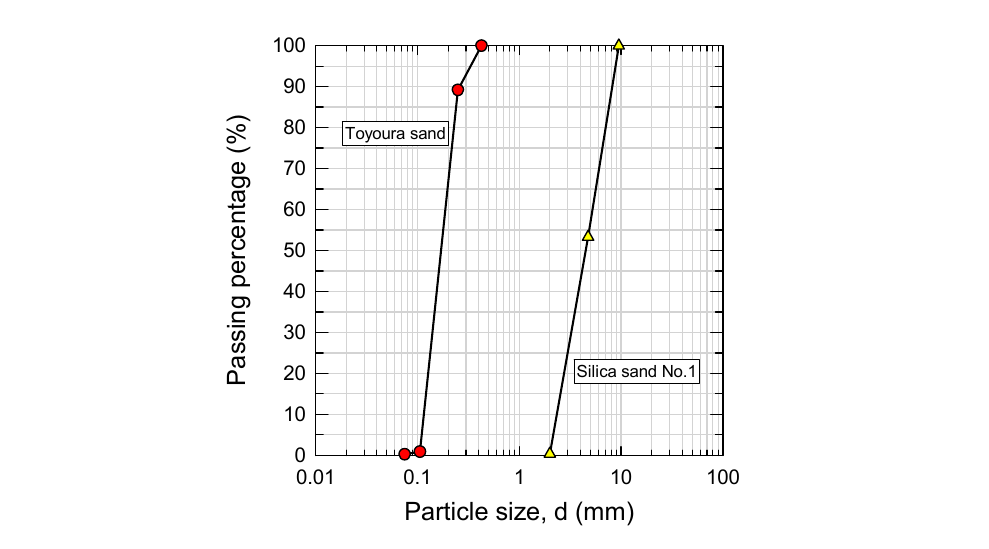
Figure 2. Grain size distribution curves of Toyoura sand and silica sand No. 1. Table 1. Physical properties and hydraulic conductivities of the soil samples. Sample Toyoura